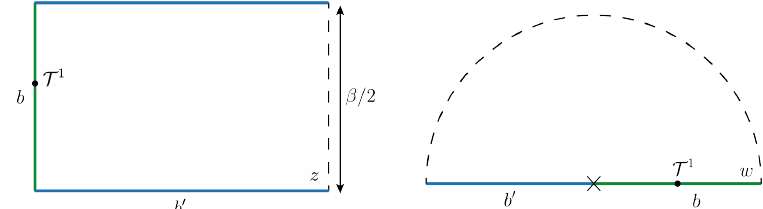
Figure 2: Euclidean boundary geometry describing the global quench in the z (left) and w (right) variable. Green / blue colors denote boundary conditions of type b / b ′ ,